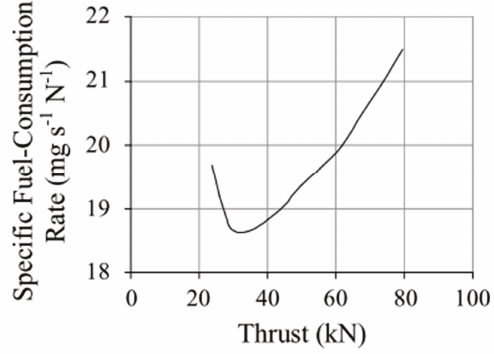
Fig. 8. The specific fuel consumption rate versus the thrust of F-100 jet engine